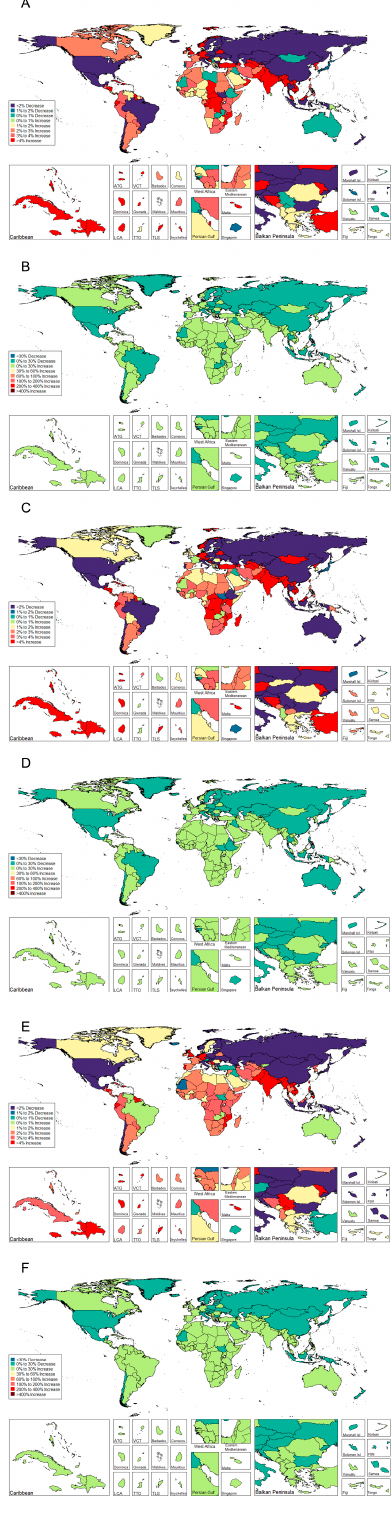
Figure 2. Percentage change and annual percentage change of age standardized incidence rate of urolithiasis stratified by gender and 195 Countries and territories. ( A ) PC of ASIR stratified 195 Countries and territories of both gender; ( B ) APC of ASIR stratified 195 Countries and territories of both gender; ( C ) PC of ASIR stratified 195 Countries and territories of male. ( D ) APC of ASIR stratified 195 Countries and territories of male; ( E ) PC of ASIR stratified 195 Countries and territories of female; ( F ) APC of ASIR stratified 195 Countries and territories of